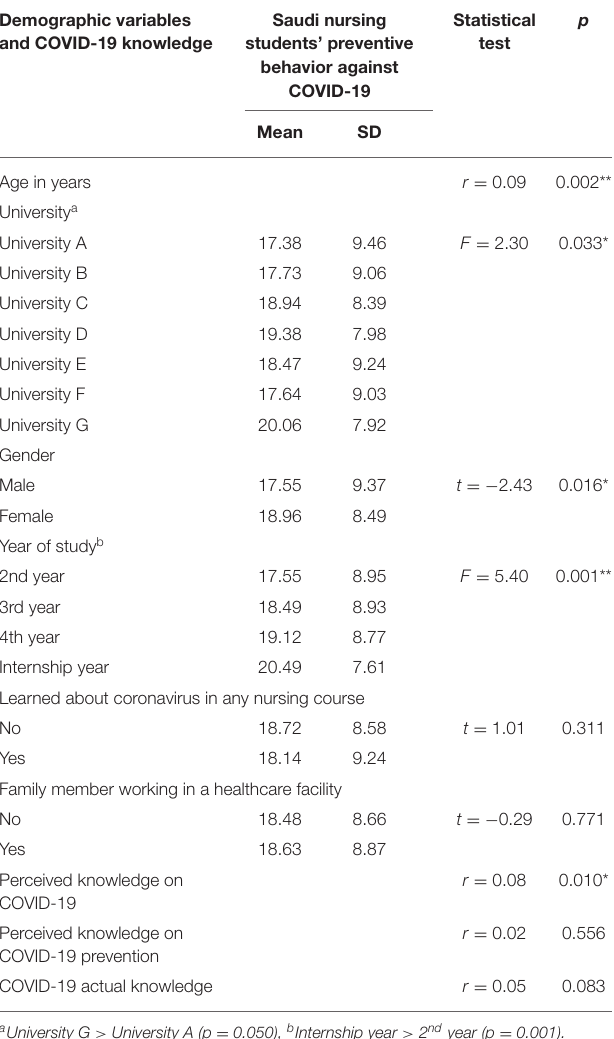
TABLE 5 | Results of the tests of associations between the Saudi nursing students’ preventive behavior and demographic variables and COVID-19 knowledge ( n =